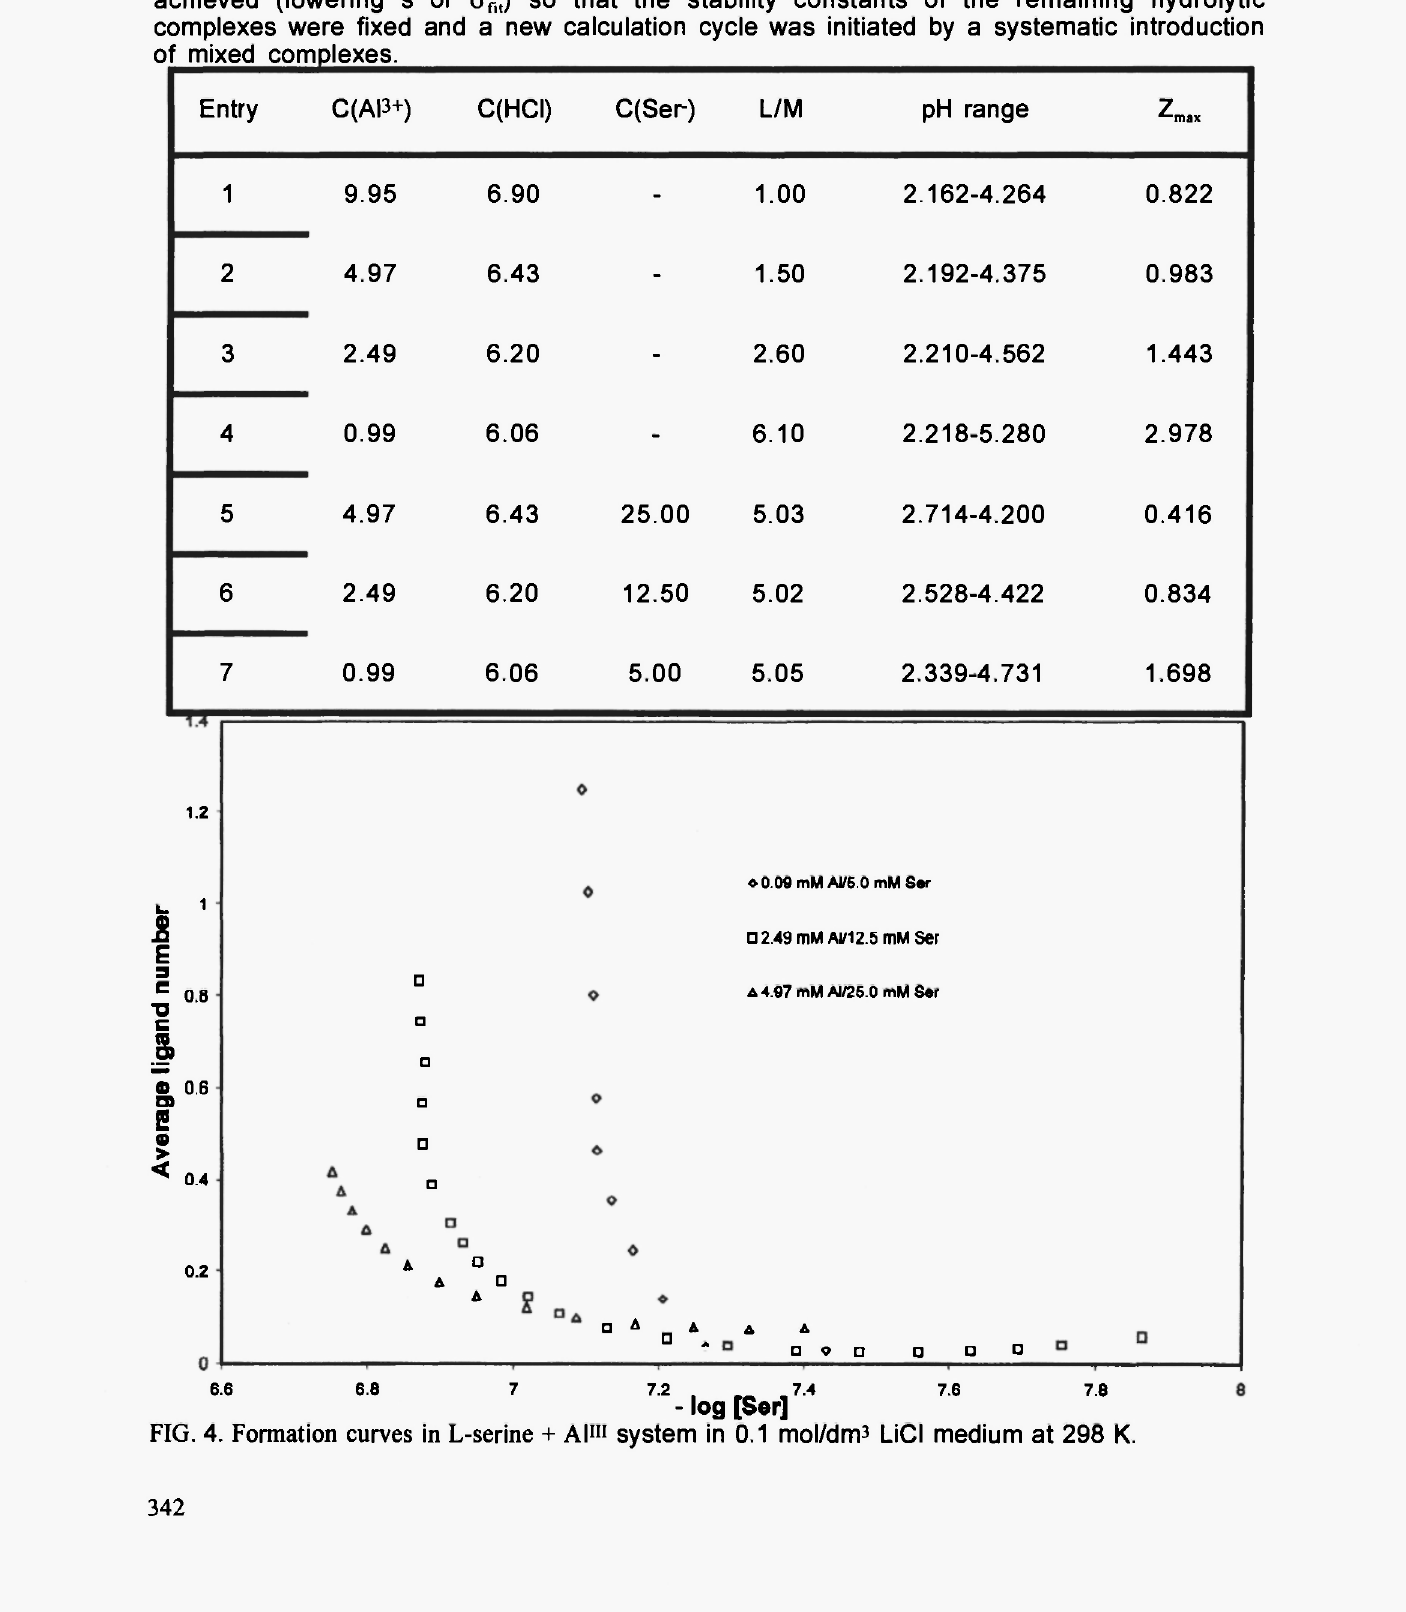
Table 4. Summary of Potentiometrie titrations of L-serine + Aim solutions in 0.1 mol/dm 3 LiCI medium, at 298 K. All concentrations are in mmol/dm3. L is total initial concentration of serine and Μ that of aluminum. Z denotes maximum average ligand number attained. In msx significant